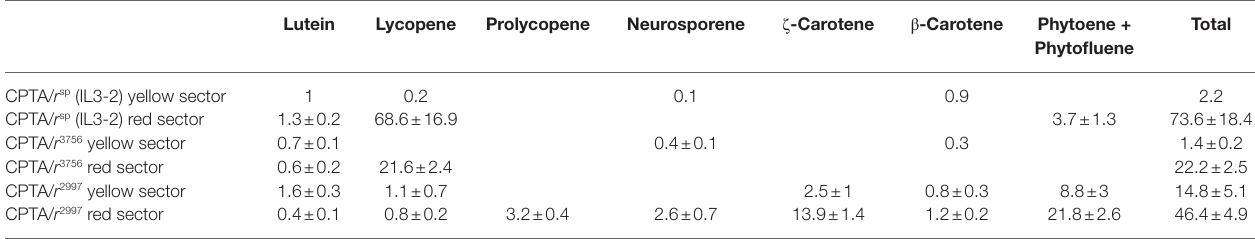
TABLE 2 | Carotenoid composition in fruit sectors.